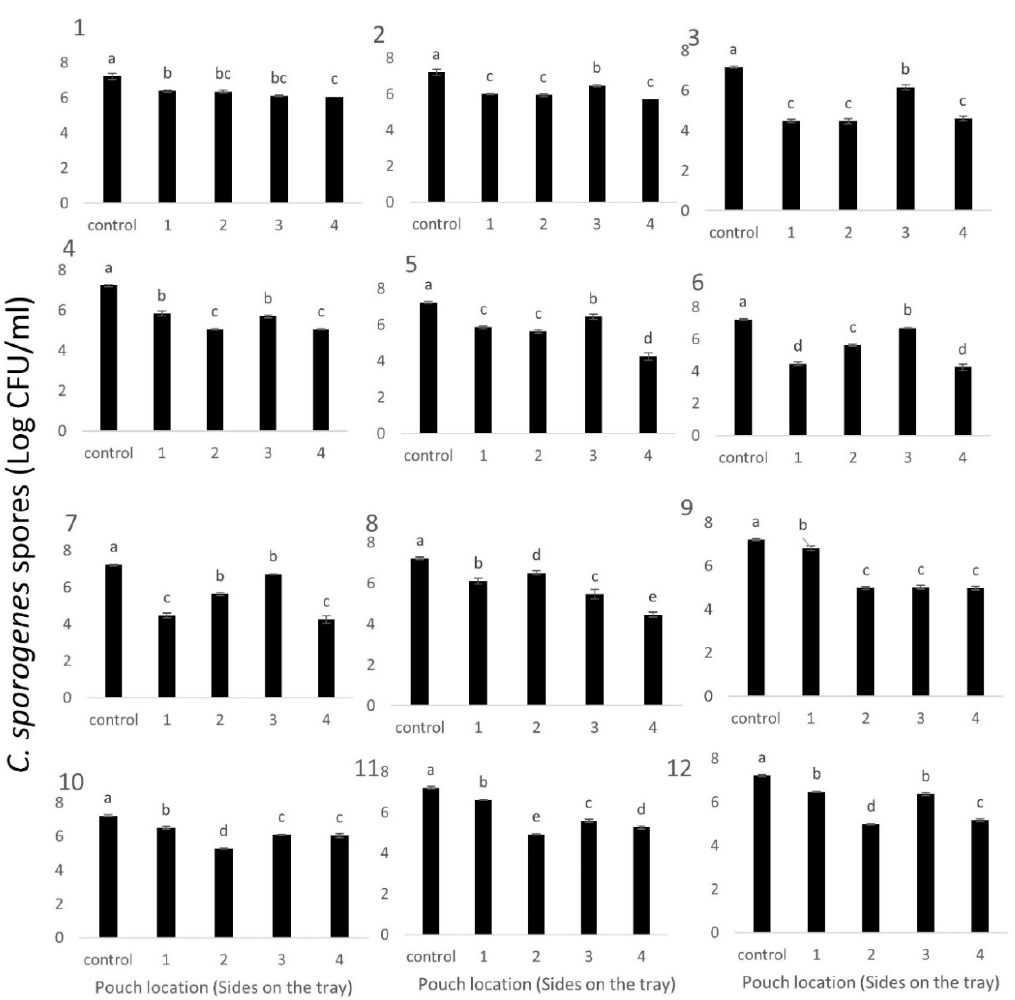
Figure 7. C. sporogenes spores in pouches surviving the CiMPAS processing (R-65) when placed vertically on four sides on each tray ( 1 – 12 ). Note: Similar letters among the bars indicate no significant difference ( p > 0.05)